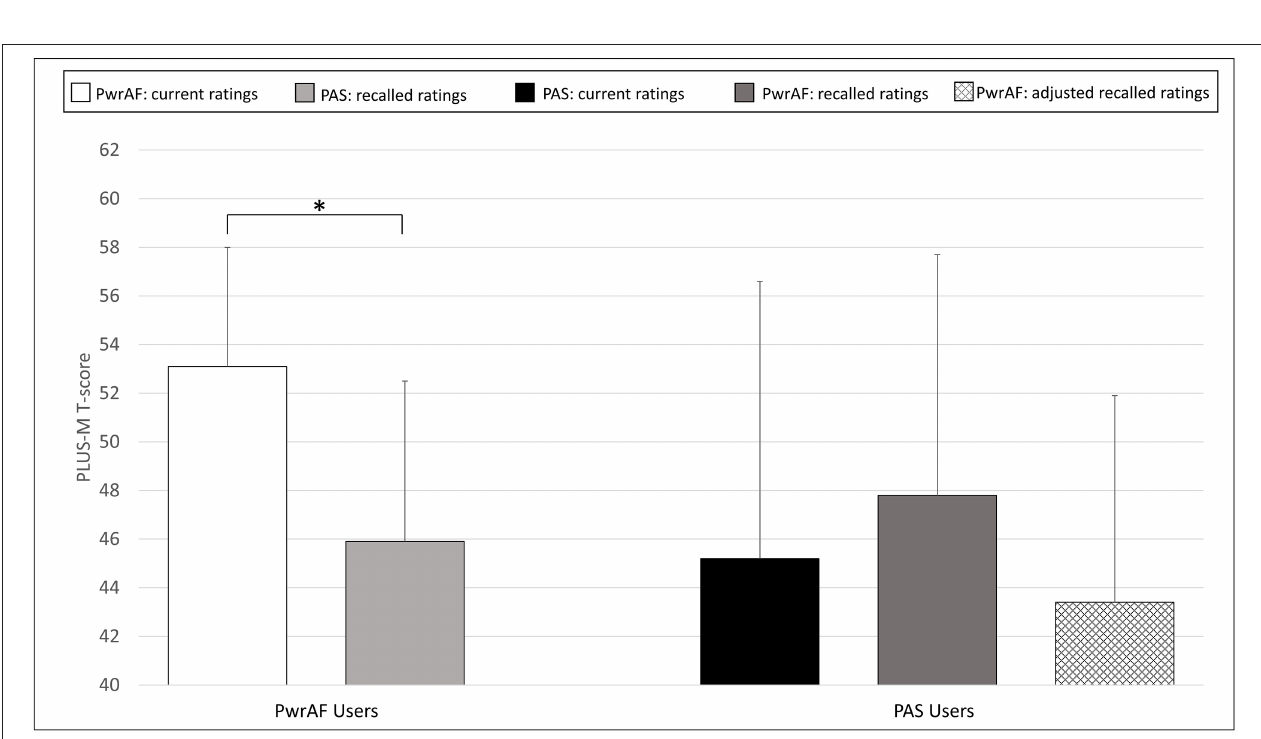
FIGURE 5 | Mean PLUS-M T-scores in current PwrAF users ( n = 6) and current PAS users ( n = 7) who reported sound knee pain ≥ 4 NPRS when using PAS. * p < 0.05 (see text for details). Differences in means of 4.5 points or greater are considered clinically meaningful.